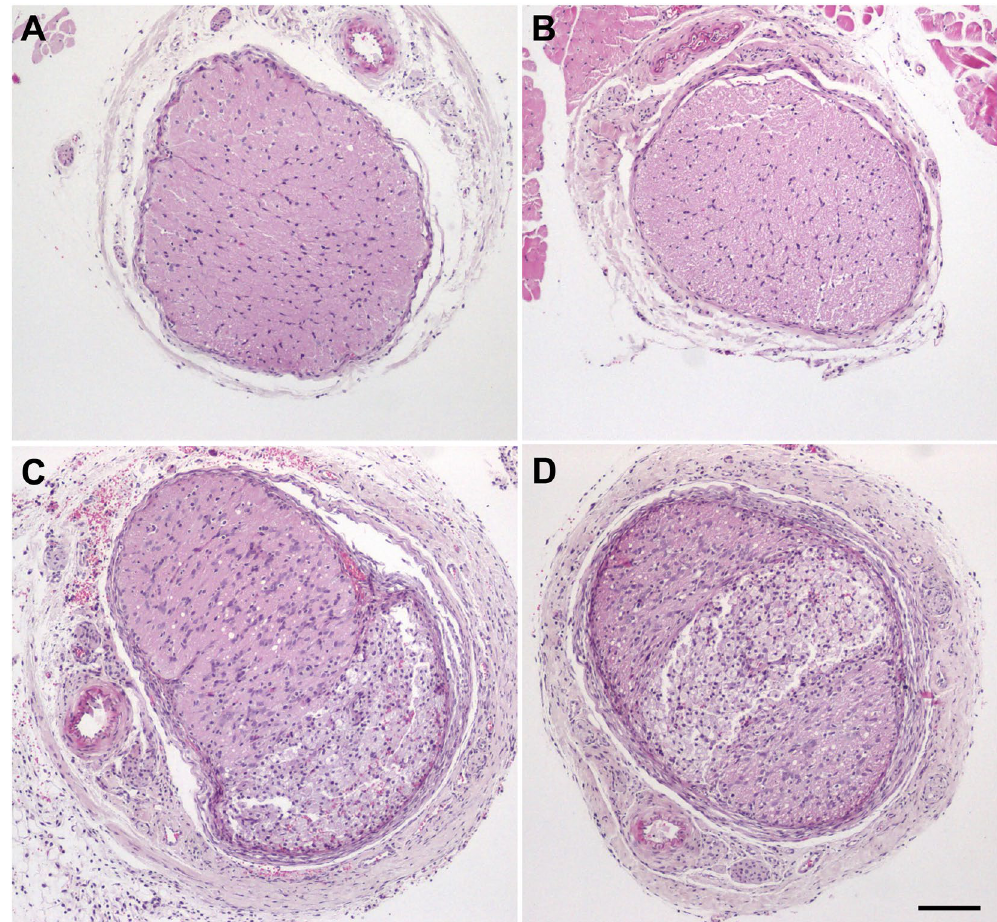
Figure 3. Representative histological images of the optic nerves of animals of the 4 experimental groups stained with hematoxylin & eosin: sham-operated ( A ), sham-operated treated with hypothermia ( B ), IONC-operated ( C ), and IONC-operated treated with hypothermia ( D ). Bar = 400 µ